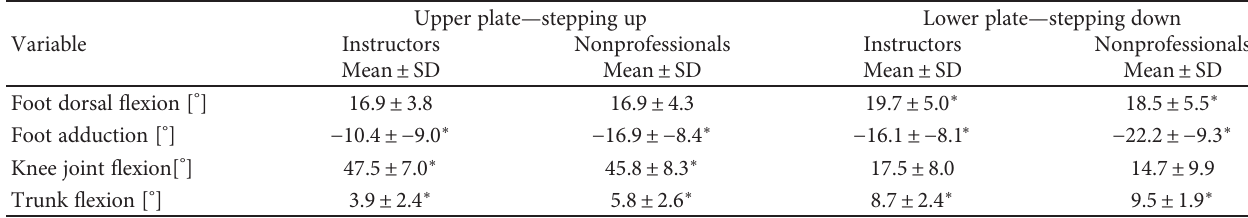
Table 2: Mean values and standard deviation (SD) angular variables obtained by the instructors and nonprofessionals when the vGRF is in its maximum value.